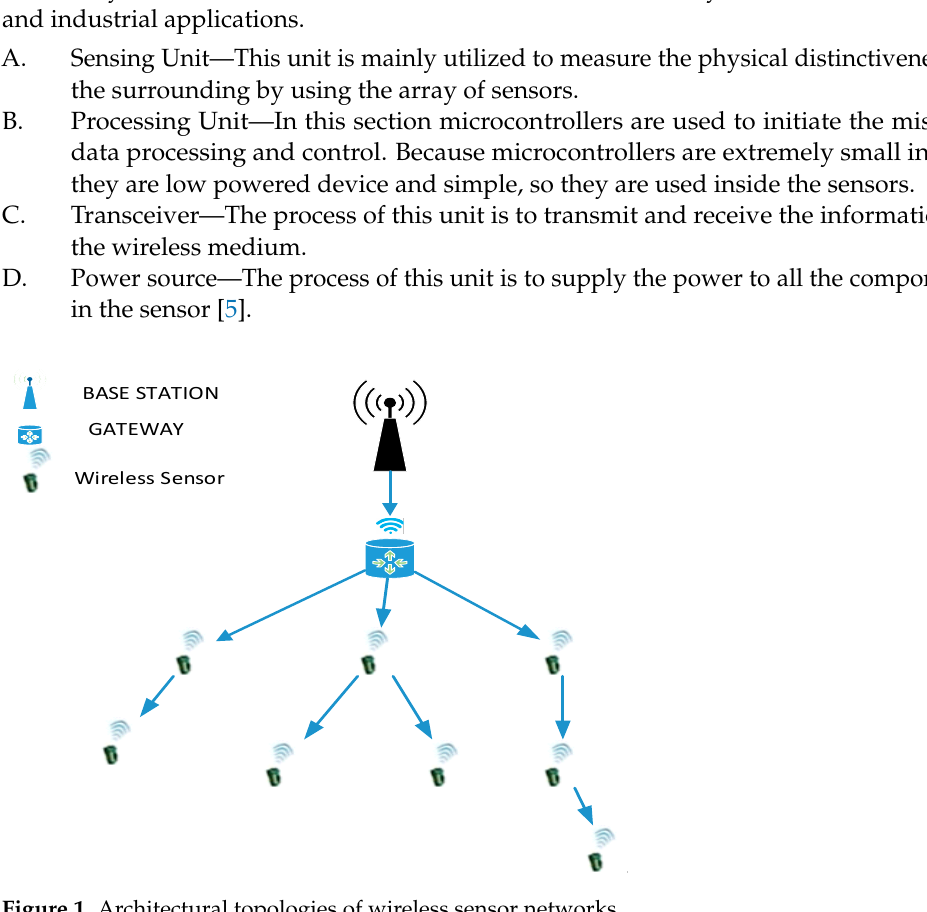
Figure 2. Components of a sensor node. A.